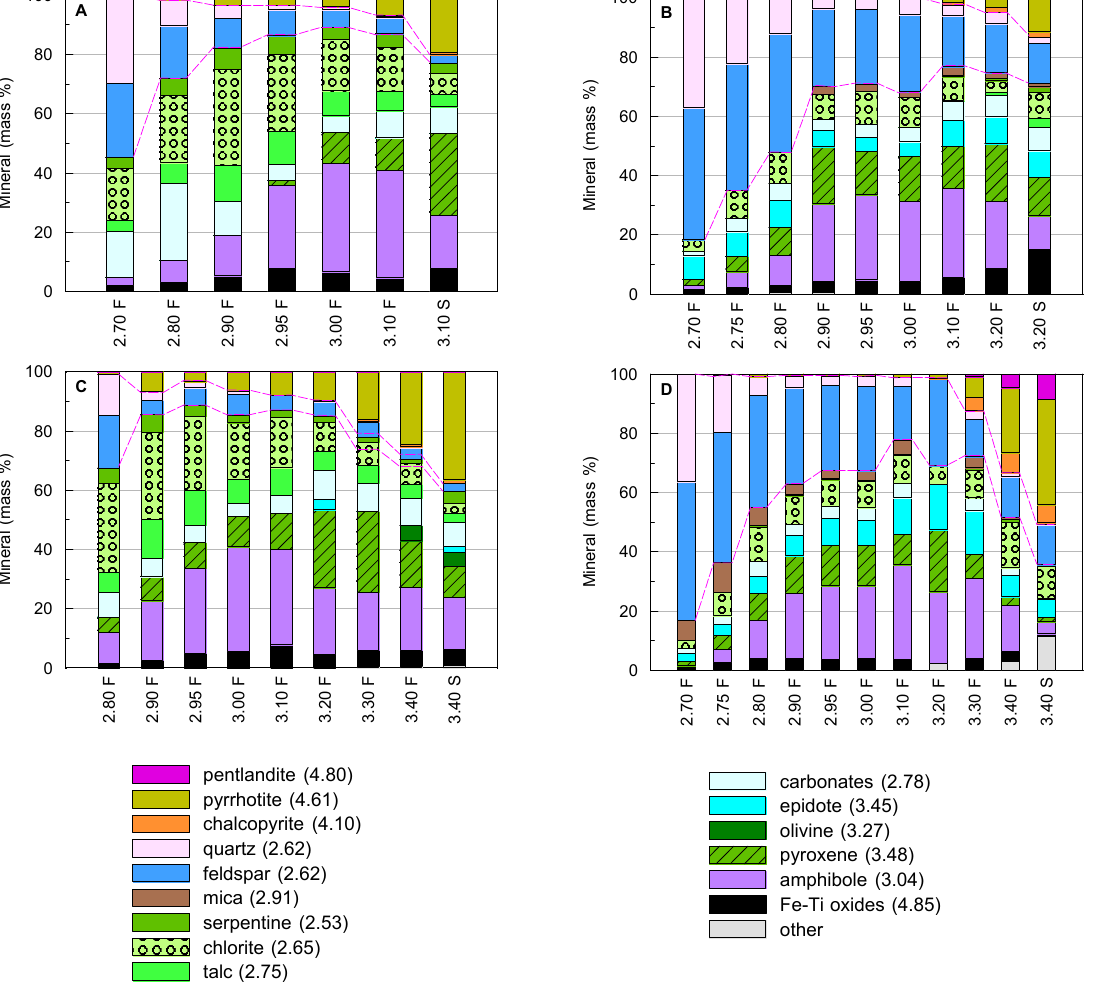
Figure 5. Bulk mineralogy of the individual density fractions for the ore A ( A ) and B ( B ) overflow, and ore A ( C ) and B ( D ) underflows. The change in quartz + feldspar content with density is shown with dotted lines, as an example of gangue separation.